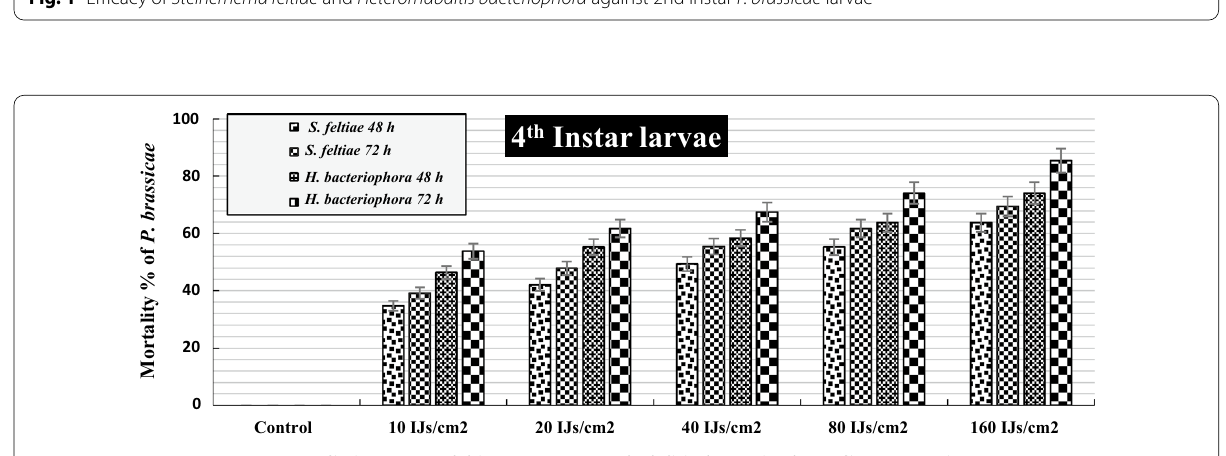
Fig. 2 Efficacy of Steinernema feltiae and Heterorhabditis bacteriophora against 4th instar P. brassicae larvae